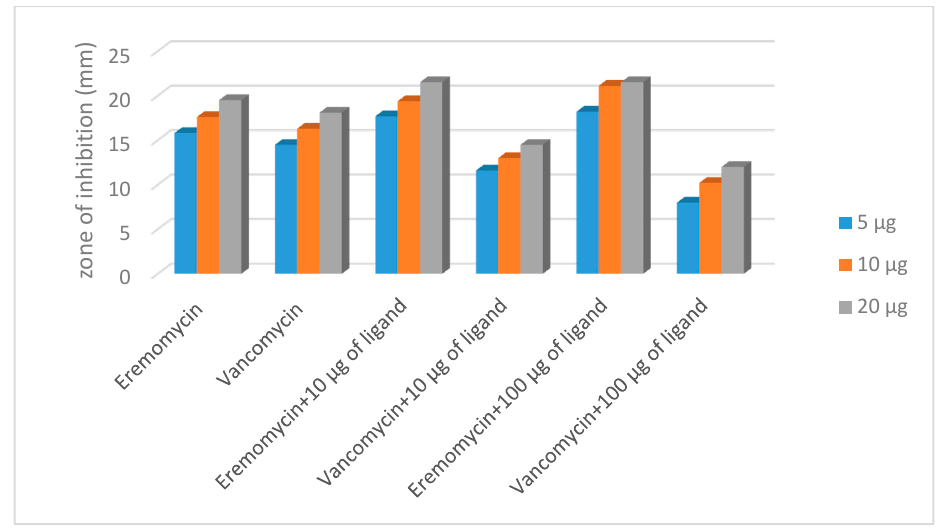
Figure 13. The change in the diameter zone inhibition in the presence antibiotics alone and in interaction with N -Ac- D -Ala- D -Ala ( S. aureus 209P).